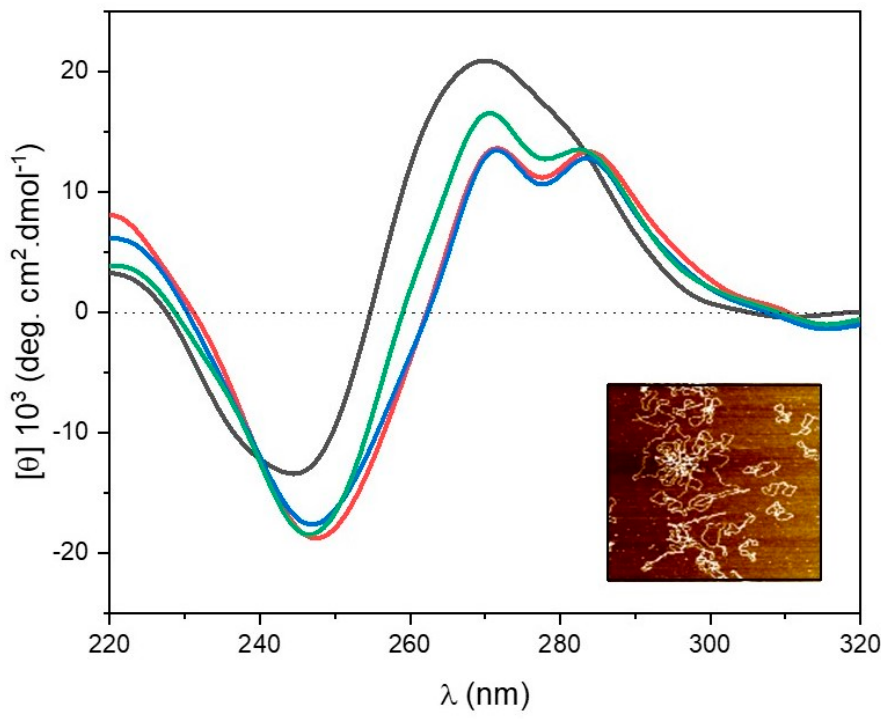
Figure 5. CD spectra of DNA (black), and in the presence of GP16_6 (N/P = 1 red, N/P = 0.5 blue, N/P = 0.25 green). In the insert: AFM image for N/P = 0.5 (see also Figure 3).